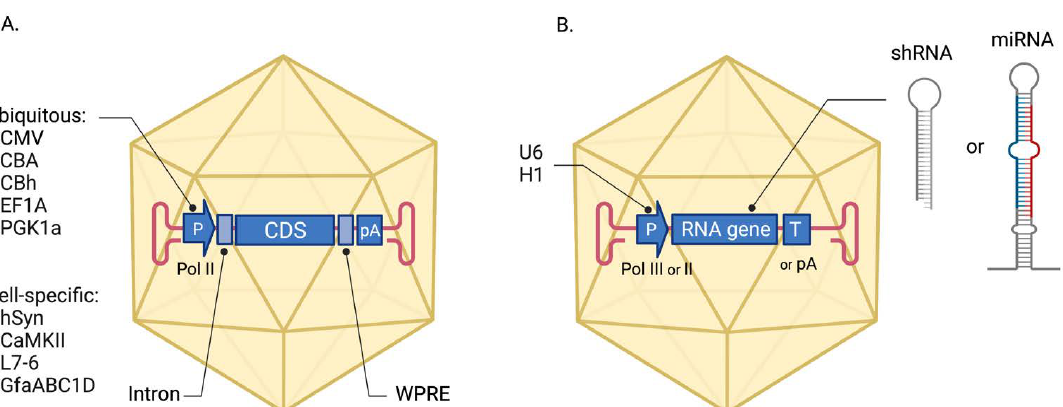
Figure 2. Design of the AAV expression vectors for modeling neurological diseases. ( A ) AAV expression cassette suitable for the transfer of protein-coding transgenes. ( B ) Configuration of the AAV vector utilized for gene suppression via RNAi mechanism. P, promoter for RNA Pol II or III as indicated; CDS, the protein-coding DNA sequence; pA, poly(A) signal for Pol II-driven transcription termination; WPRE, woodchuck hepatitis virus posttranscriptional regulatory element; T, T-stretch for Pol III-driven transcription termination; shRNA, small hairpin RNA; miRNA, artificial microRNA.